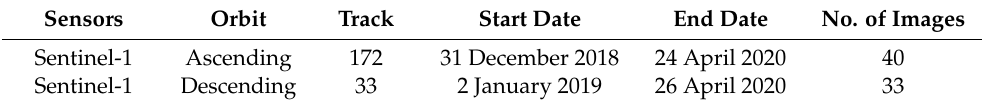
Table 1. Basic parameters of SAR